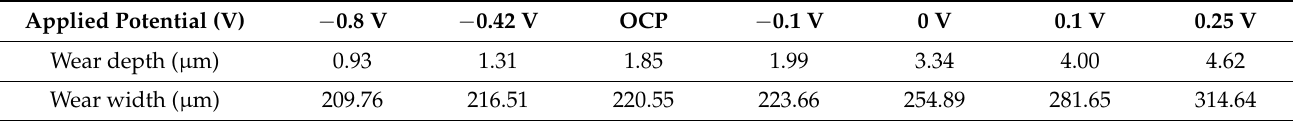
Figure 6. The three-dimensional image of the worn surface of CoCrNi in 3.5 wt. % NaCl solution ( f ), 0.25 V ( g ). Table 2. Depth and width of wear tracks of CoCrNi under different applied